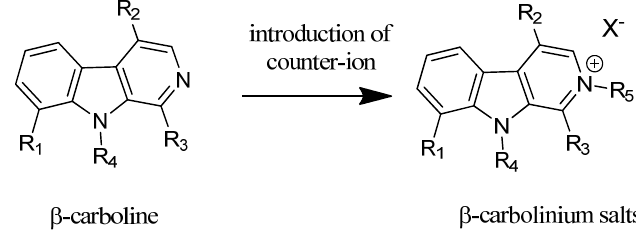
Figure 4. The modification of general β‐ carboline compounds into the β‐ carbolinium salts for enhanced anti ‐ malarial activity of Picrasma quassioides [4] . anti-malarial activity of Picrasma quassioides